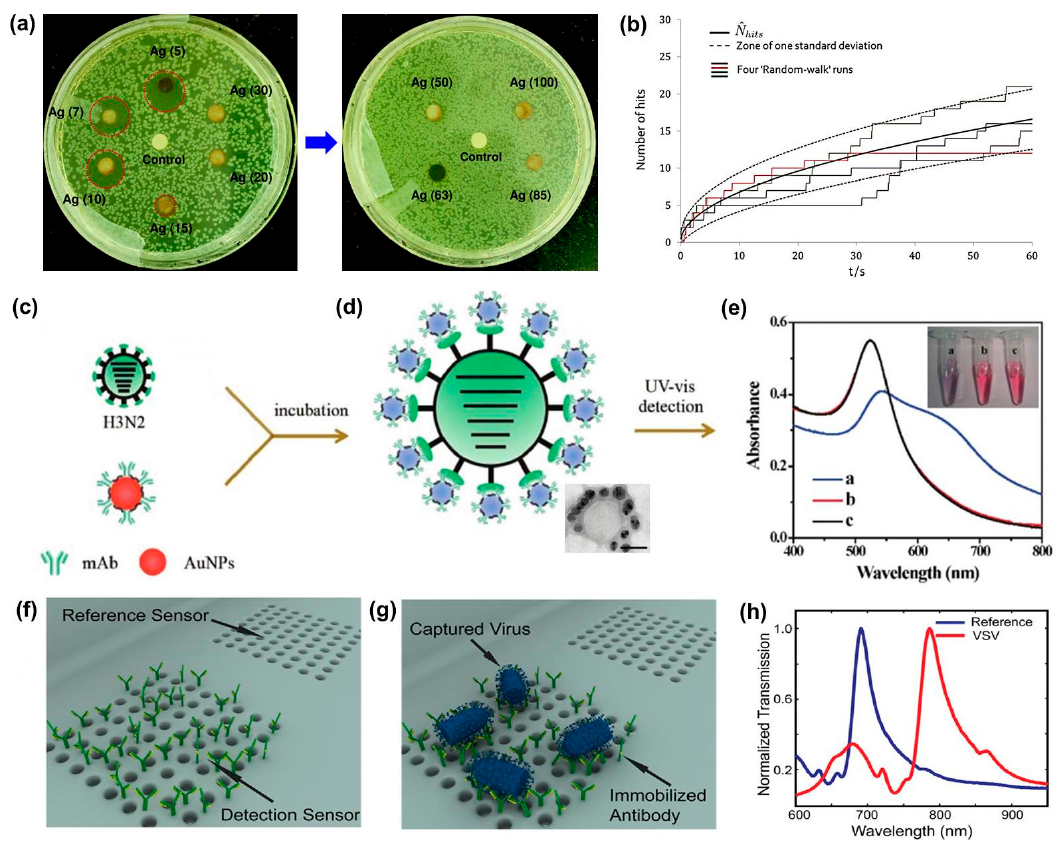
Figure 1. ( a ) photo of a disk diffusion test for a variety of different sized silver nanoparticles against the E. coli MTCC 443 strain (reproduced from Agnihotri et al. [8]); ( b ) graph depicting four random-walk simulation runs. The solid black line represents the cumulative number of total hits, while the dashed lines represent zone standard deviation (reproduced from Eloul et al. [11]); ( c – e ) flow chart describing the colorimetric detection of influenza virus particles (H3N2) using functionalized gold nanoparticles (AuNPs) (reproduced from Liu et al. [15]); ( c ) the infected sample and functionalized AuNPs are mixed and incubated for 30 min; ( d ) H3N2 and AuNPs bind due to the antibody–antigen interaction, with tunneling electron microscope (TEM) image of resulting aggregate below; ( e ) rearrangement of AuNPs around the viral particles results in a blue shift with intensity that correlates with H3N2 concentration; ( f – h ) illustration depicting a nanohole detection sensor and associated spectral response curve: ( f ) detection sensor with antibody; ( g ) capture of vesicular stomatitis virus (VSV) on the sensor; and ( h ) shift of plasmon resonance due to the accumulation of viral particles (reproduced from Yanik et al. [26]).